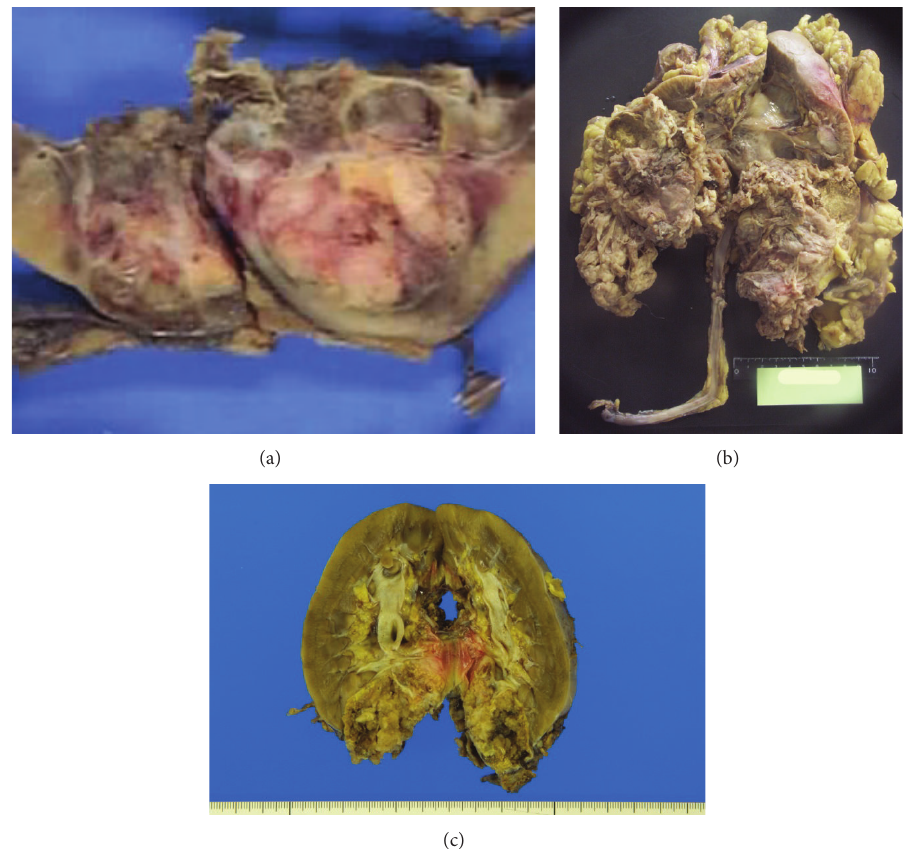
Figure 1: Gross finding of the tumor. (a) The tumor occupied the upper pole of the kidney. The cut surface was mottled with whitish color and hemorrhage (Case 1). (b) The resected kidney contained a brownish and fragile tumor in the lower half (Case 2). (c) The tumor was milky white in color and occupied the lower pole of the kidney (Case 3).